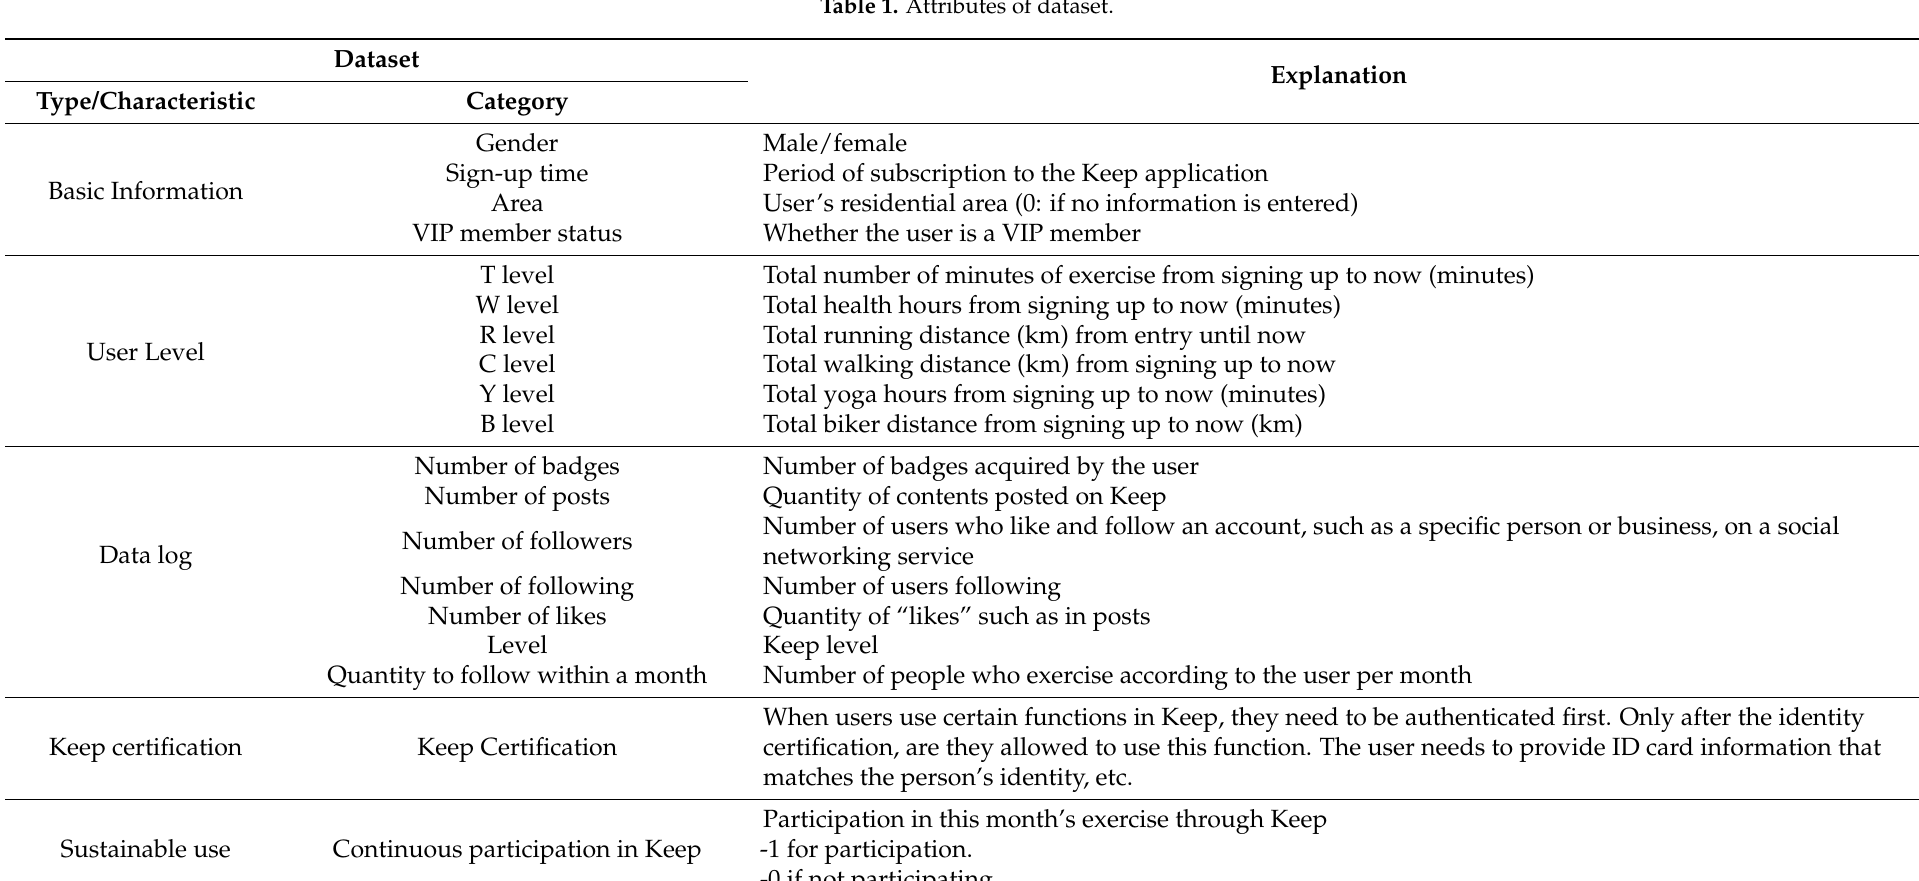
Table 1. Attributes of